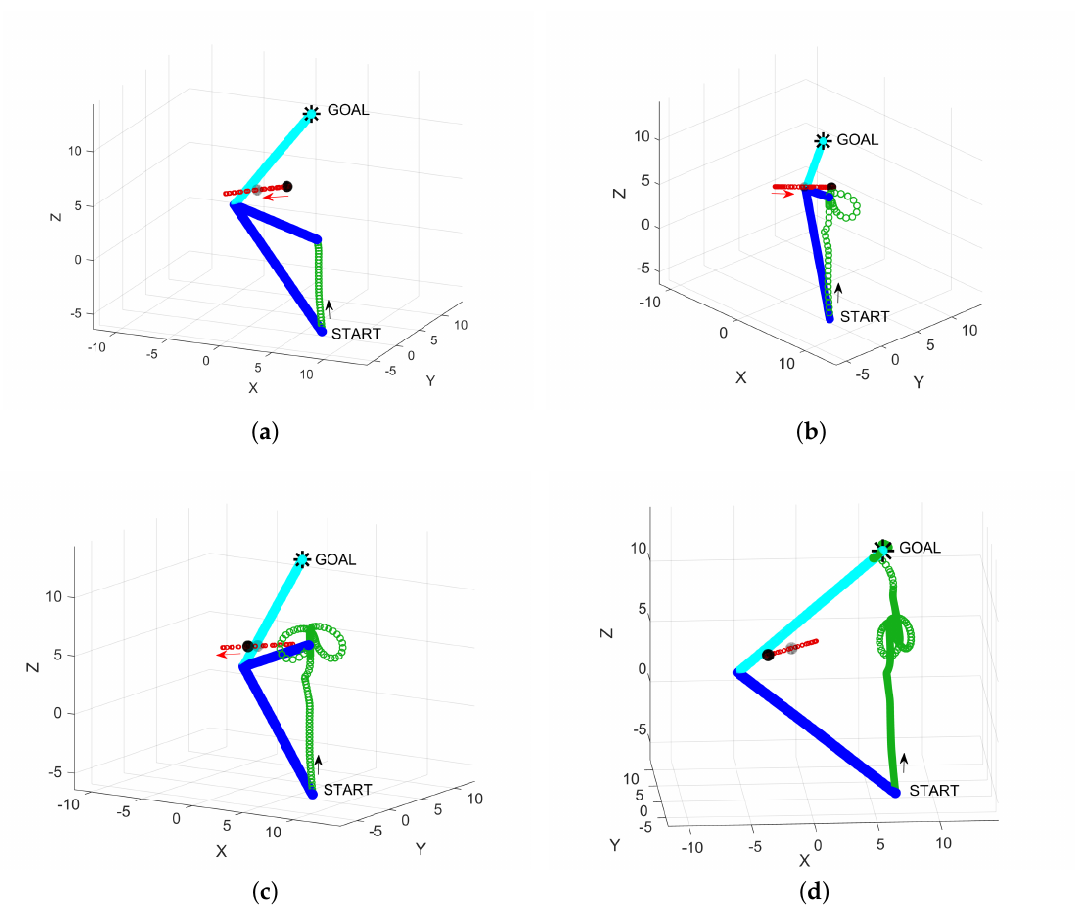
Figure 8. In blue, the starting position and the position in the snapshot of the tool, while in light-blue, the goal pose. In black, the position of the sphere in the snapshot, while in transparent black, its starting position. In red, the trajectory of the sphere. In green, the trajectory of the EE. The black arrows show the direction of the movement of the sphere in that snapshot. ( a ) First snapshot; ( b ) second snapshot; ( c ) third snapshot; ( d ) final snapshot.